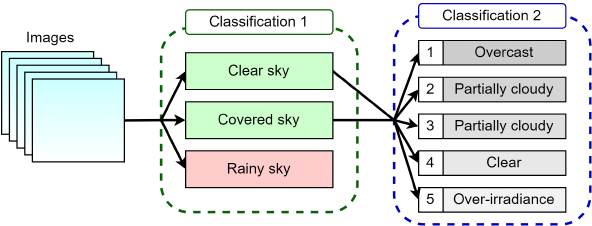
Figure 4. Double-step classification scheme.